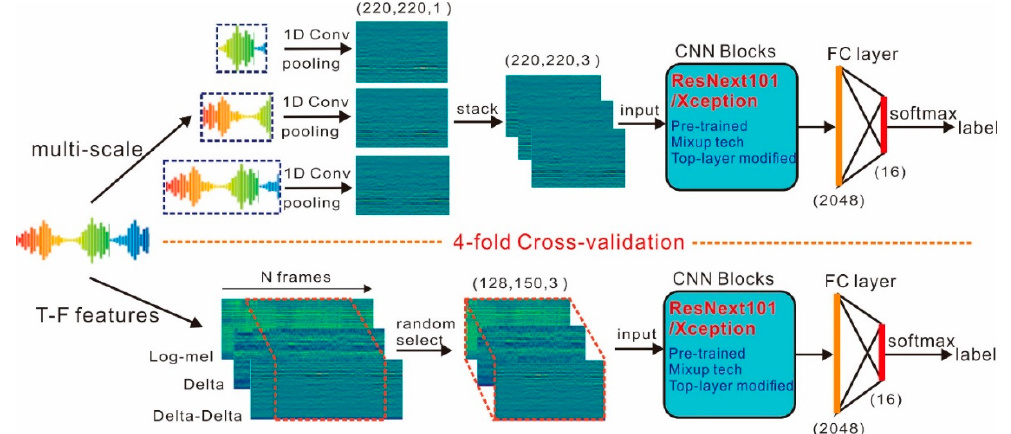
Figure 1. Illustration of the proposed architecture.